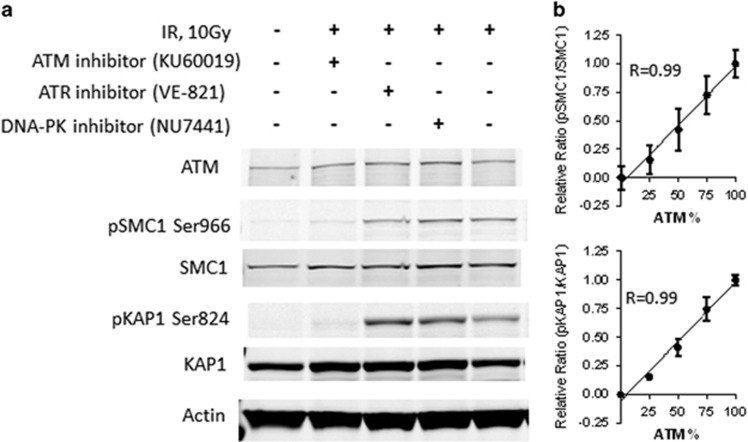
Identification of ATM substrates. (a) ATM-repleted (GM16667) cells were pre-treated with inhibitors of ATM, ATR and DNA-PK (KU60019, VE-821 and NU-7441, respectively) for 1 h before subjecting cells to 10 Gy of irradiation. Cell lysates were harvested 1 h after irradiation. The result is representative of two independent experiments. (b) ATM-deficient and -repleted cells were combined in the indicated percentages. Quantitations of pSMC1/SMC1 and pKAP1/KAP1 values were plotted against the ATM percentage. Results are based on data from four experiments.